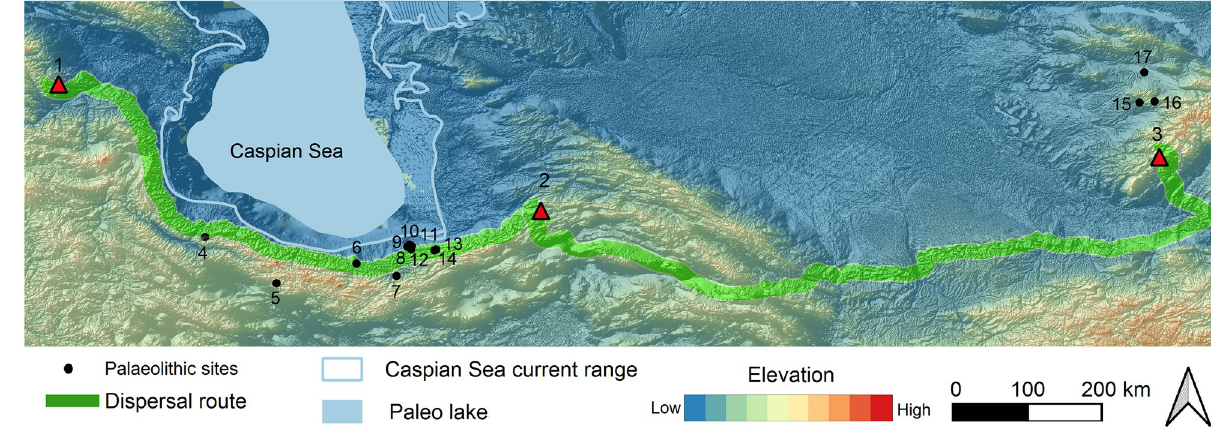
Fig 10. The southern dispersal route with 30 km buffer zone as highly potential hominin settlements (1. Azokh and Taglar, 2. Keyaram, 3. Teshik-Tash, 4. Darband, 5. Eskouldar, 6. Garmroud, 7. Liben, 8. Komishani, 9. Kolet, 10. Rostamkola, 11. Shoupari, 12. Khanesar, 13. Wezwar, 14. Kiyasar, 15. Anghilak, 16. Aman Kutan, 17. Khodjamazgil.